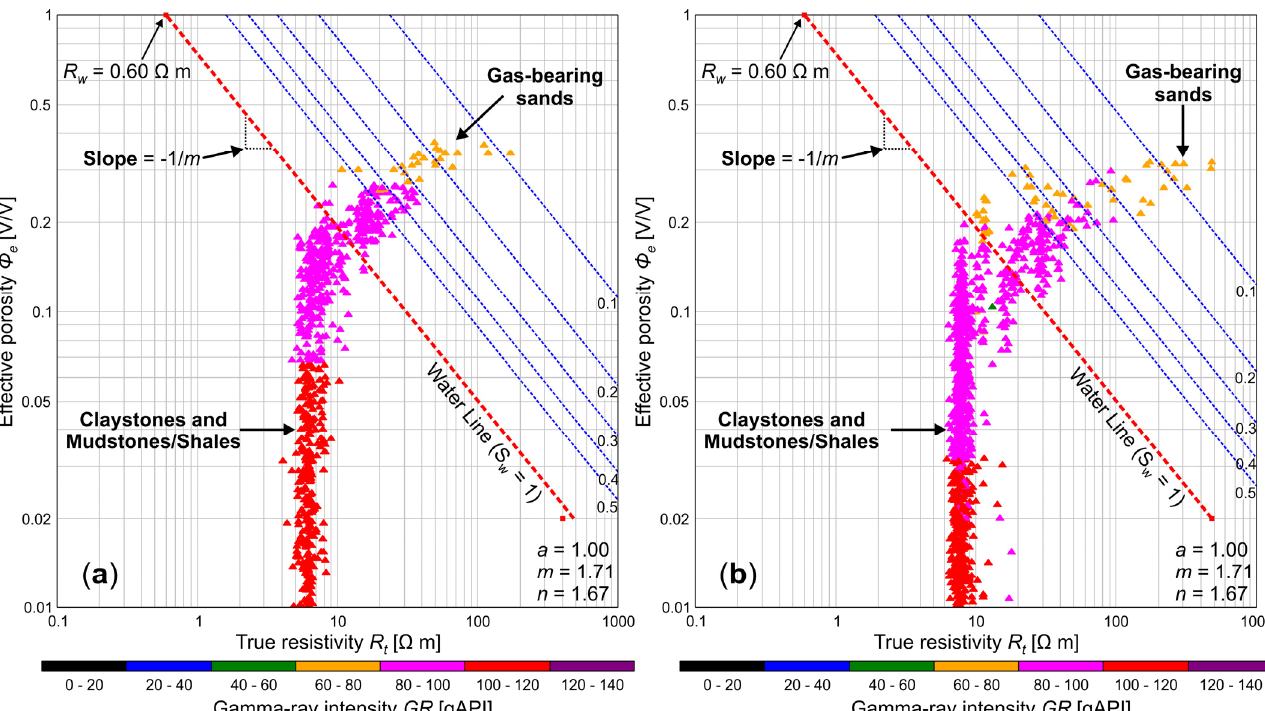
12 Figure 12. Pickett-type resistivity–porosity crossplots based on the effective porosity ( φ e ) resulting from well log interpreta- tion and parameters ( ρ ma , m , n ) obtained from core analyses (RCAL and SCAL). ( a ) A-1 well (681 data levels); ( b ) A-2 well (933 data